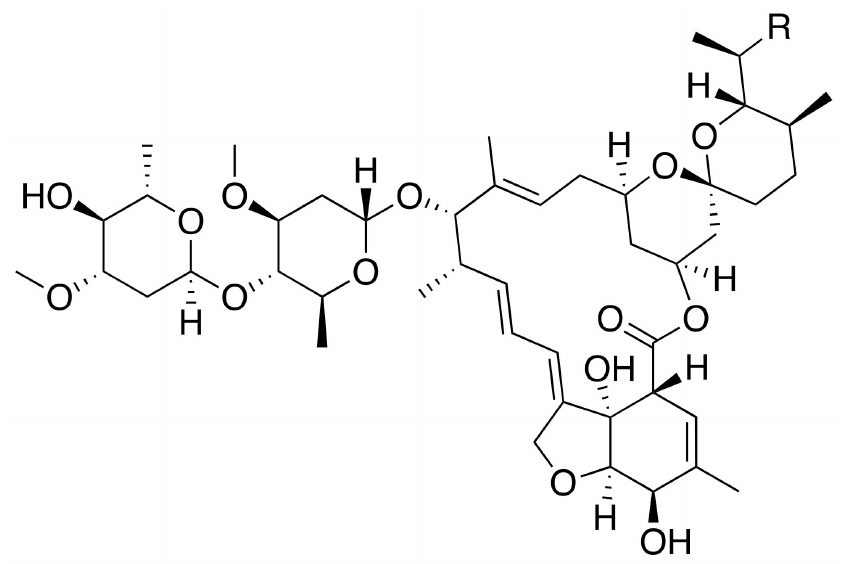
Figure 1. Ivermectin as a mixture of two components B 1a (R = Et) and B 1b (R =